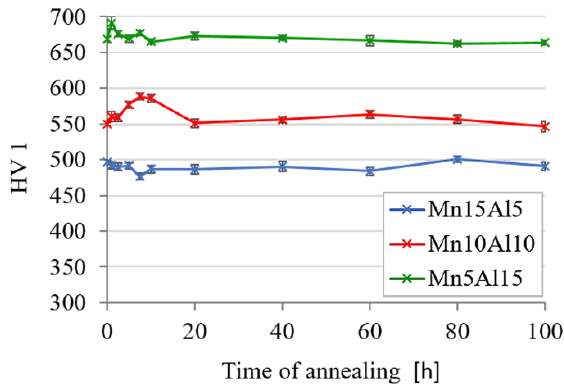
Figure 11. Thermal stability of the MA + SPS alloys as a hardness change during annealing at 800 ◦ C. (Error bars represent confidence intervals).